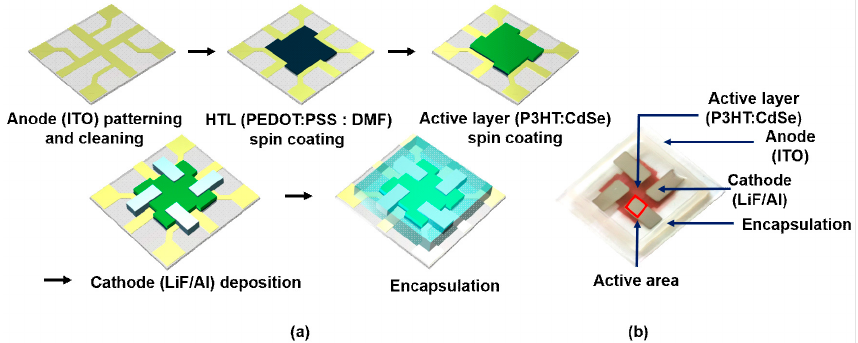
Figure 2. ( a ) Process flow of the hybrid detector with the P3HT:CdSe quantum dots (QDs) active layer, and ( b ) the actual image of the fabricated detector.